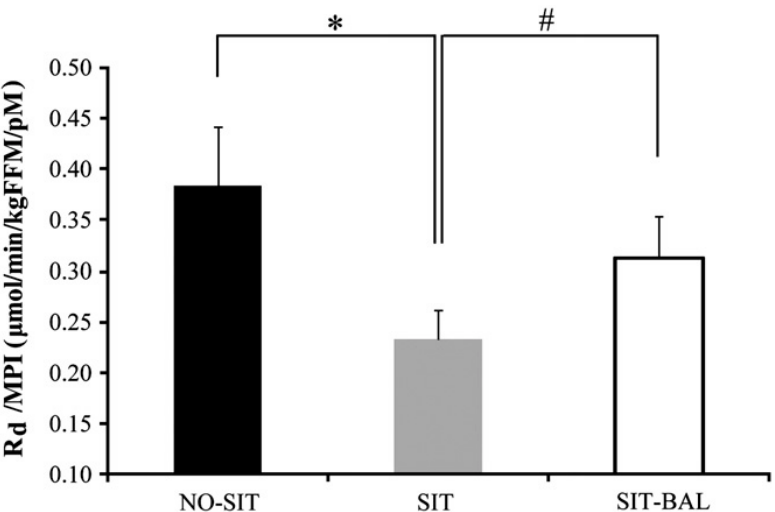
Figure 4. Whole-body insulin action (R d /MPI) assessed during the continuous infusion of glucose across the three conditions. Values are mean ± SEM. MPI, mean of 140-, 145-, and 150-min plasma insulin concentrations. Insulin action was 39% lower in SIT compared with NO-SIT (* p < 0.001). Insulin action was 26% lower in SIT compared with SIT-BAL ( # p = 0.04). Insulin action was 18% lower in SIT-BAL compared with NO-SIT ( p = 0.07). Republished with permission of Canadian Science Publishing from Stephens et al., 2011 [49]; permission conveyed through Copyright Clearance Center, Inc.